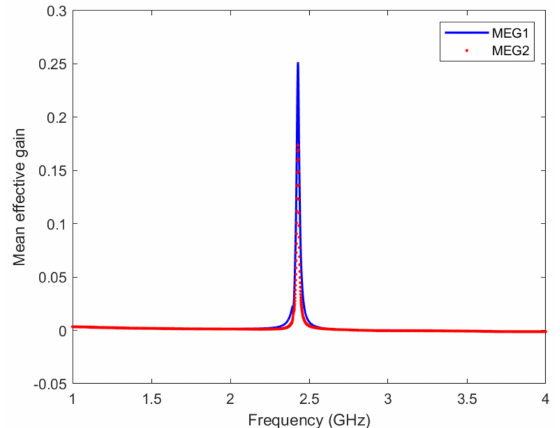
Figure 18. The MEG of the proposed MIMO antenna. (MEG1) is when Ant 1, Ant 3, Ant 4, or Ant 6 is under observation, however, the second curve (MEG2) is when Ant 2 or Ant 5 is under